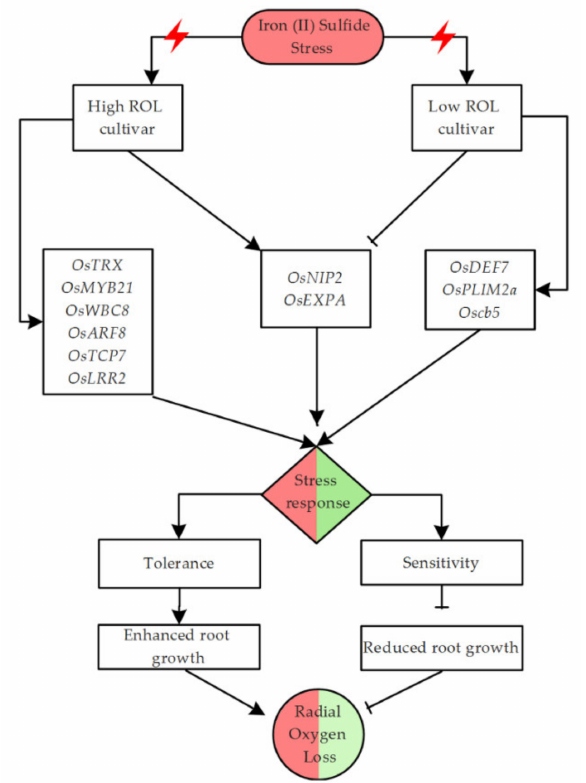
Figure 6. Hypothetical signaling model in response to FeS-mediated radial oxygen loss (ROL) in rice. When plants are exposed to an environmental stimuli, they activate signaling cascades as part of the defense mechanism, which include the induction of a wide range of stress-responsive genes, including transcription factors. The interplay between the genes and other components of the adaptive response mechanism determines the degree of the tolerance. Iron (II) sulfide (FeS) is shown here to significantly increase the transcript abundance of OsTRX , OsMYB21 , OsWBC8 , OsARF8 , OsTCP7 , and OsLRR2 in Milyang352 (high ROL cultivar). In the same way, OsDEF7 , OsPLIM2a , and Oscb5 is highly induced in 93-11 (low ROL cultivar), while OsNIP2 and OsEXPA were differentially regulated. In addition, exogenous application of FeS is shown to cause reduction in root growth of 93-11 but not in Milyang352, which resulted in different stress response levels and ROL patterns. Continuous lines with an arrow at their tips indicate a positive or induction (of gene expression or roots growth), whereas, continuous lines with a perpendicular bar at one end suggest a negative regulation or inhibition (of gene expression or roots growth). Red/green color schemes in the shapes indicates high/low response or ROL level, respectively. This model was designed using ConceptDraw PRO v. 10.3.2.114 (© 2022–2022 CS Odessa Corp., San Jose, CA 95113-1116, USA) and edited in Adobe ® Photoshop ® CS6 (v. 13.0.1 × 32, © 2022–2012 Adobe Systems Incorporated,